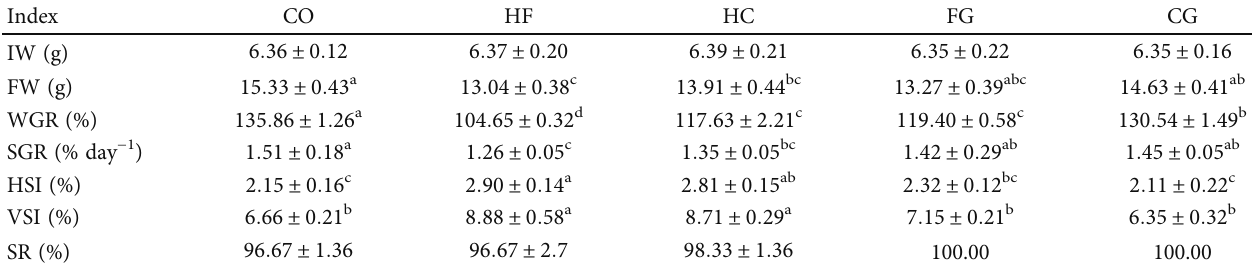
Table 3: Growth performance and biological parameters of common carp fed di ff erent experimental diets.